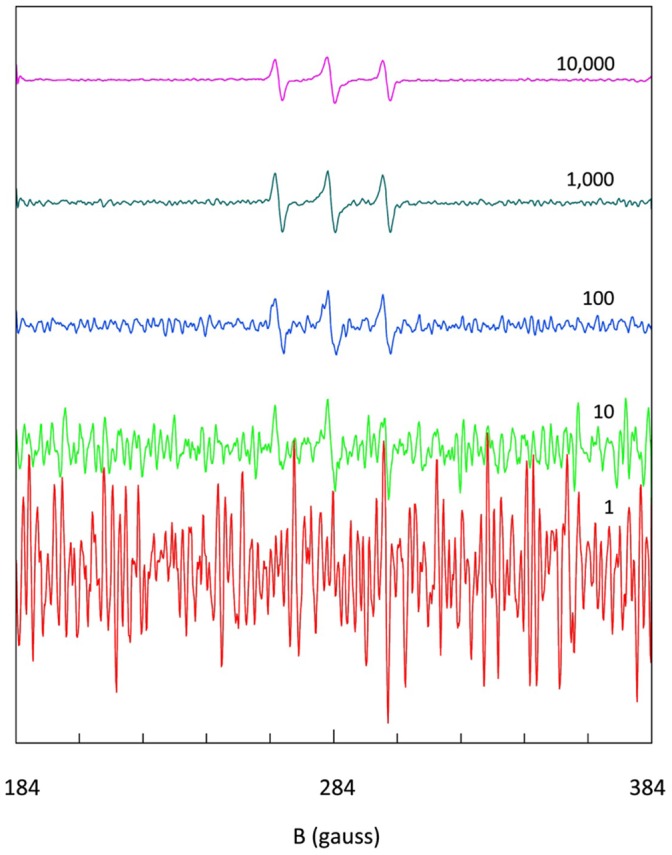
Estimation of tempo detection limit at 800 MHz.The 12 m cell was filled with 300 µM HO-tempo in 100 mM KC,l and increasing numbers of averages were collected of 10+10 s forward-return scans. From the differentiated spectrum of 10,000 averages (67 hours data colletion) a detection limit of circa 5 µM was determined.